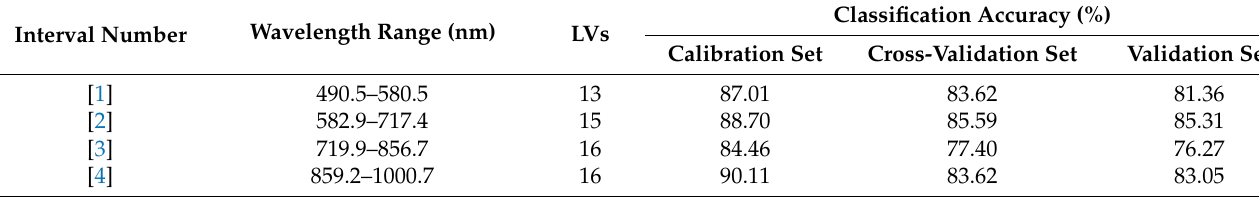
Table 3. Results of PLSDA model based on each